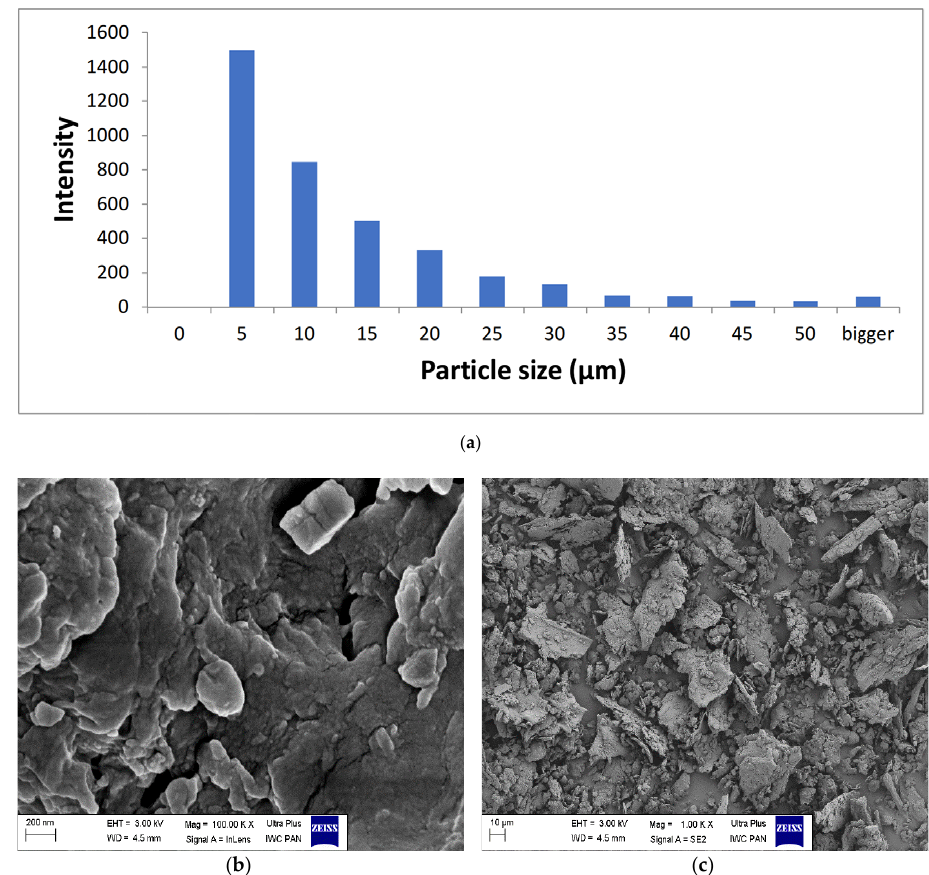
Figure 4. Histogram of the filler particle size ( a ) and SEM images of grounded horsetail under magnification: ( b ) 100.00× ( c ) 1.00×.